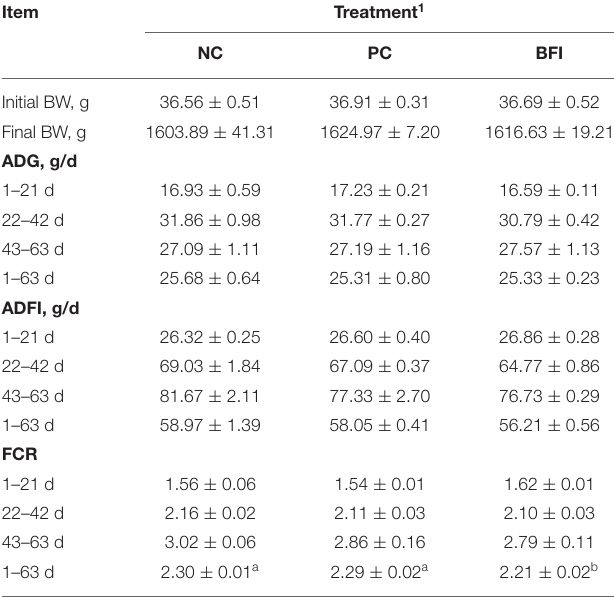
TABLE 2 | Effect of dietary supplementation with heat-inactivated compound probiotics on the growth performance in yellow-feathered broilers.